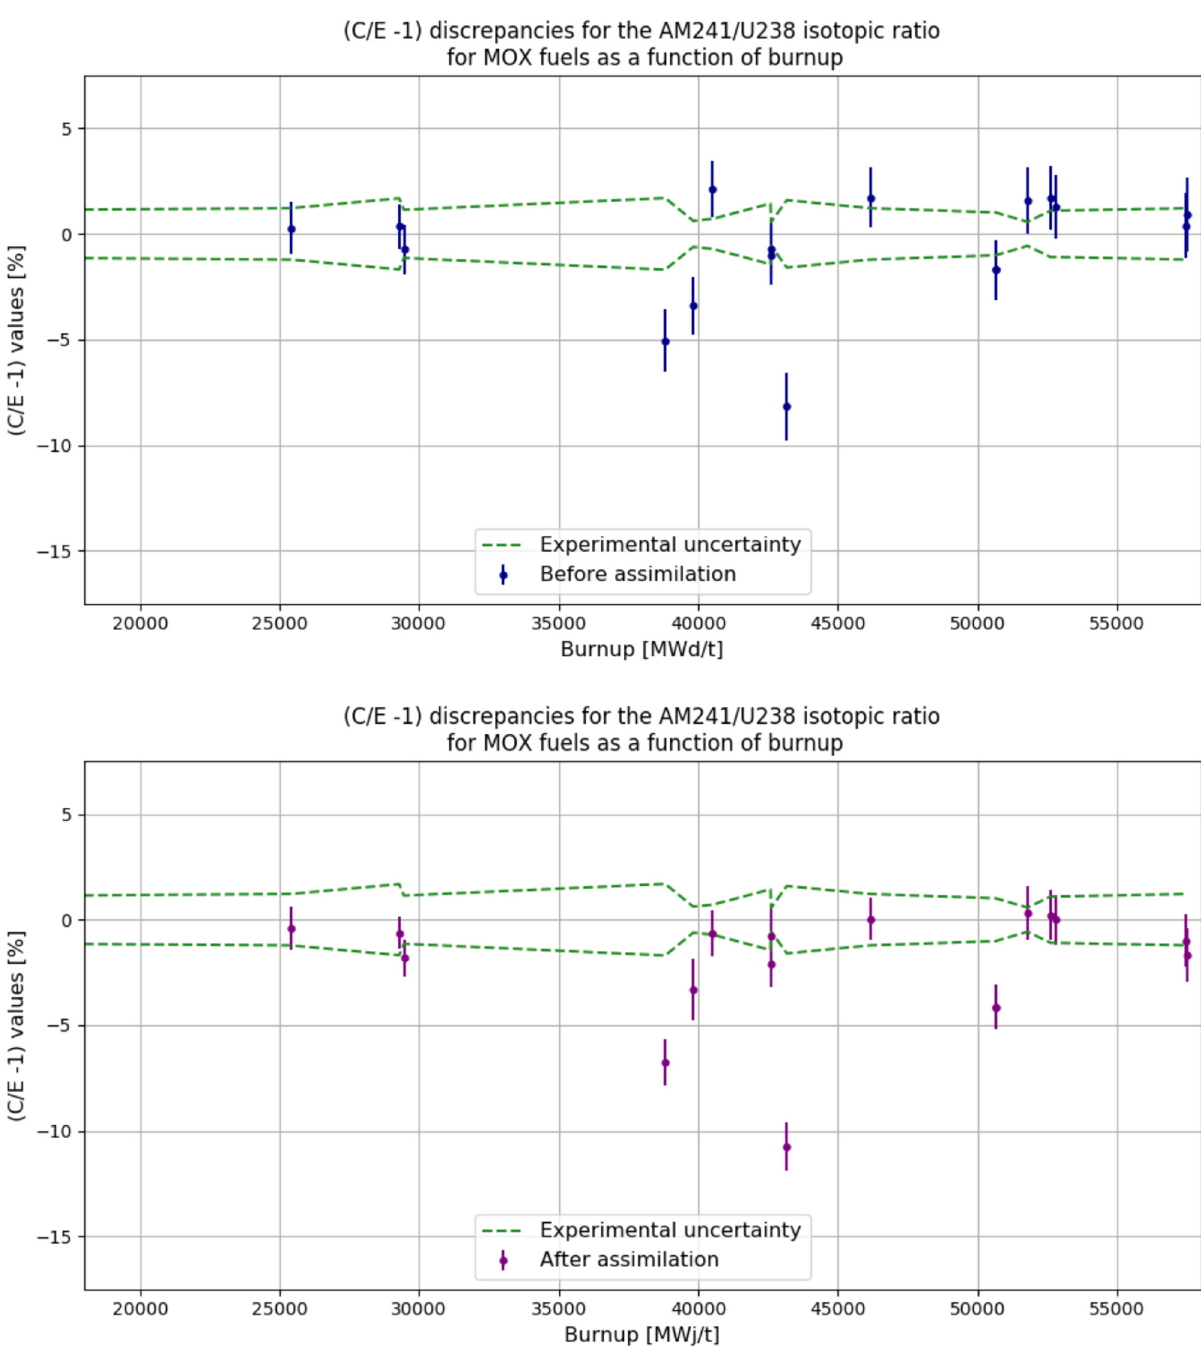
Fig. 6. Evolution of the calculated-to-experimental discrepancies before and after integral data assimilation for the 241 Am/ 238 U isotopic ratio in MOX